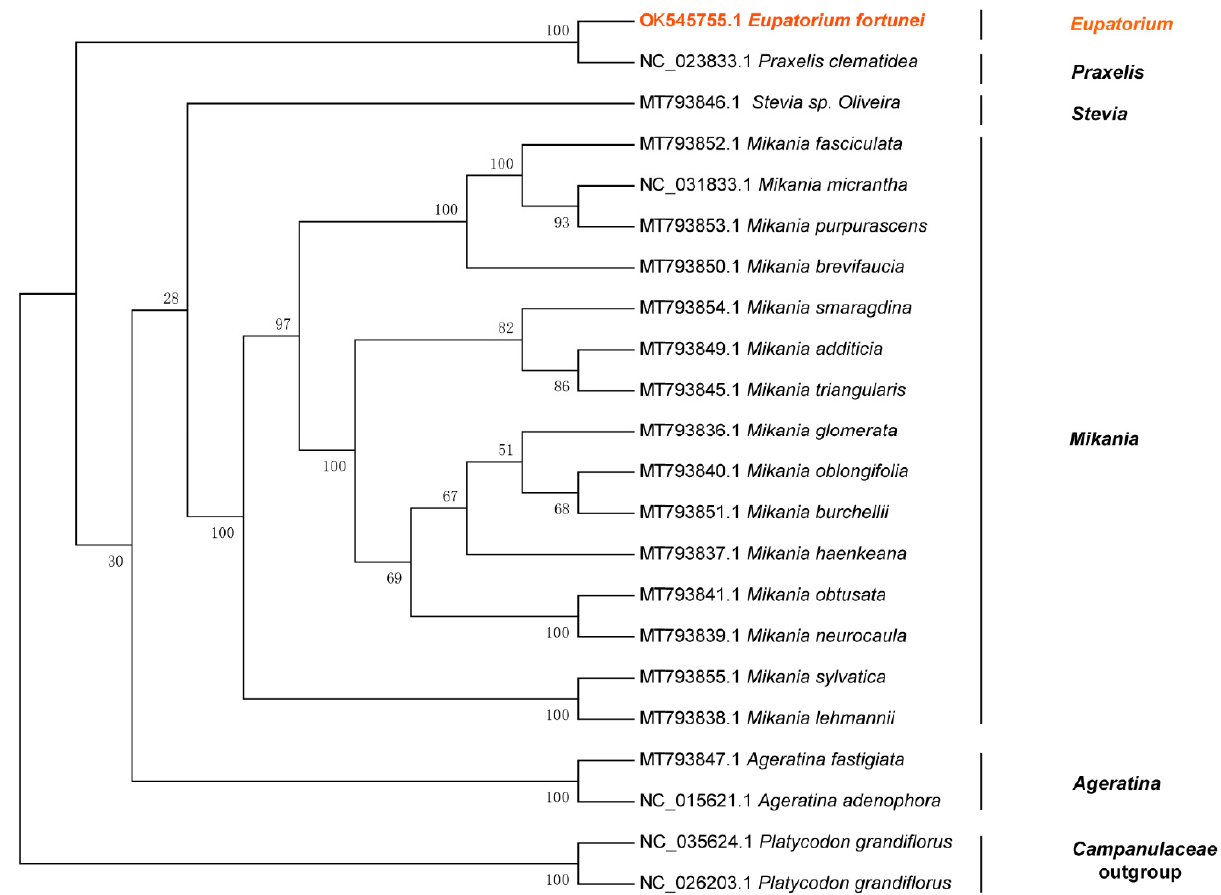
Figure 10. Phylogenetic relationship of 22 species inferred from maximum likelihood (ML). ML tree constructed based on 19 protein-coding genes (CDS) and the species E. fortunei is marked in